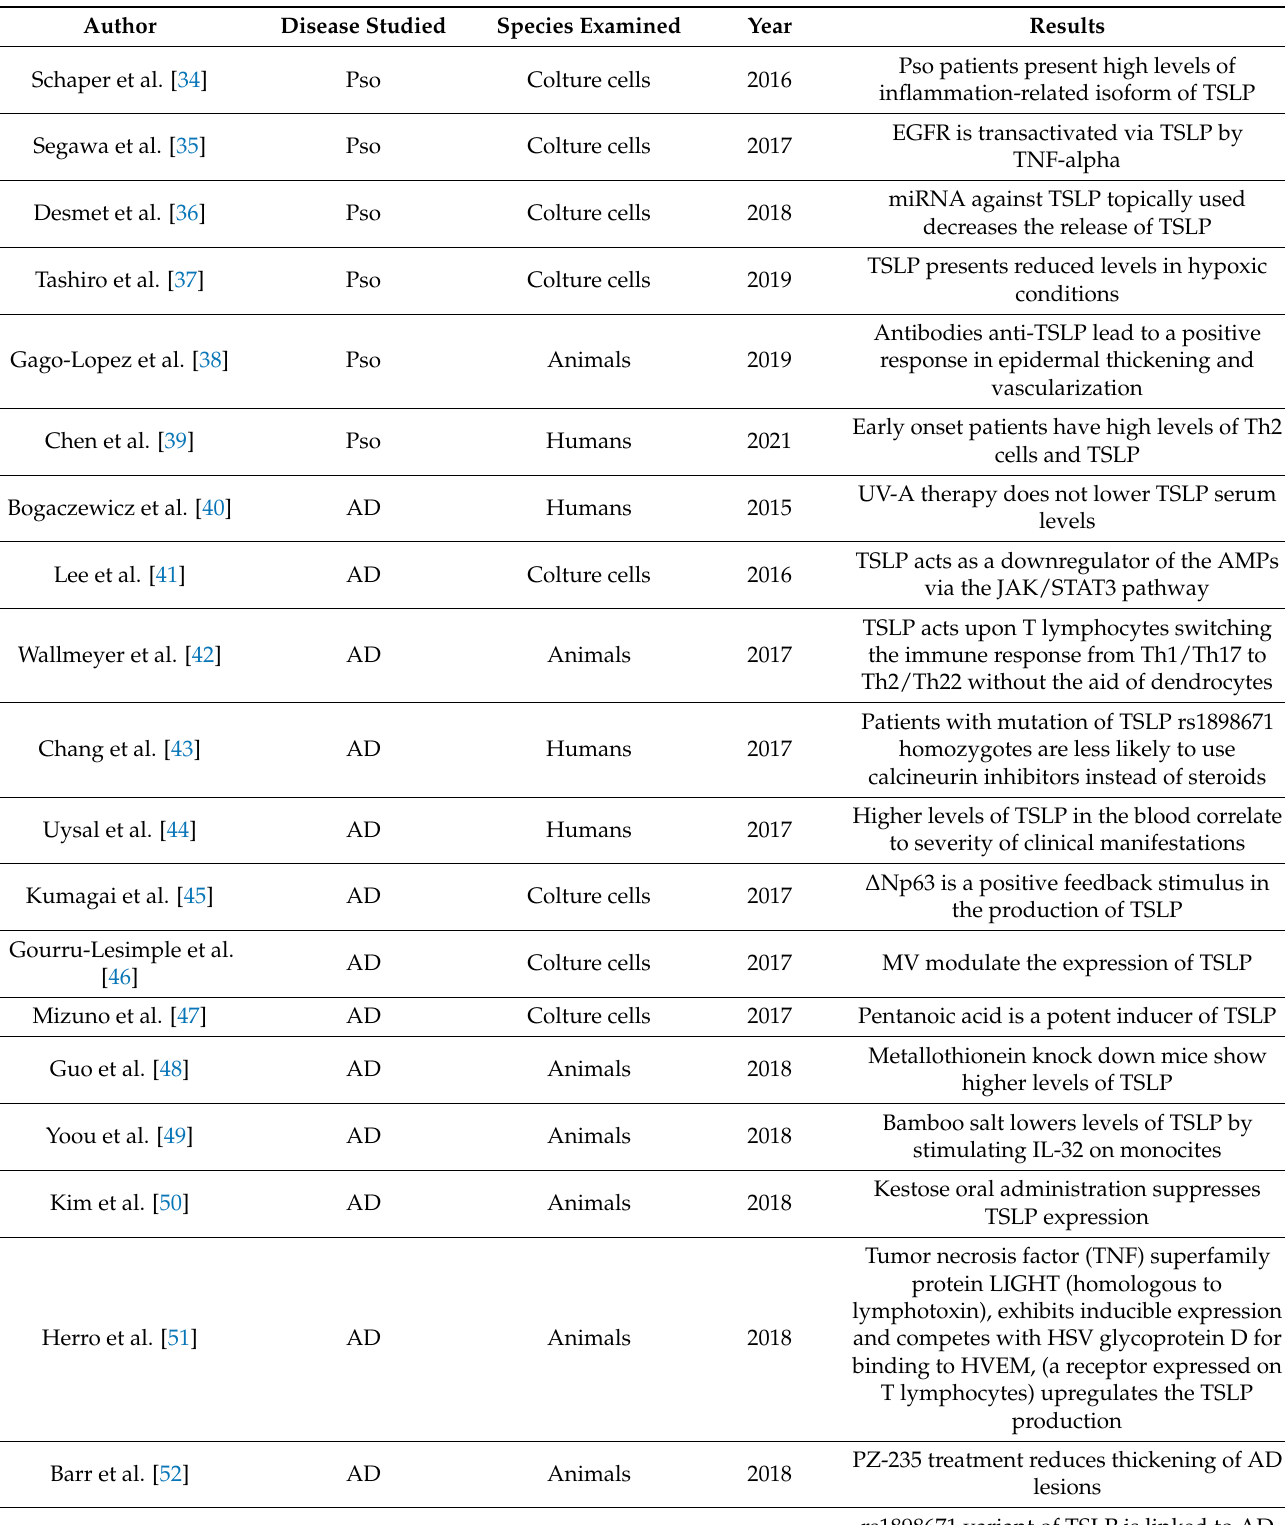
Table 3. TSLP and skin. Results include psoriasis and atopic dermatitis. The results are ordered by year and a quick recap was produced by author’s name, disease, specimens used and